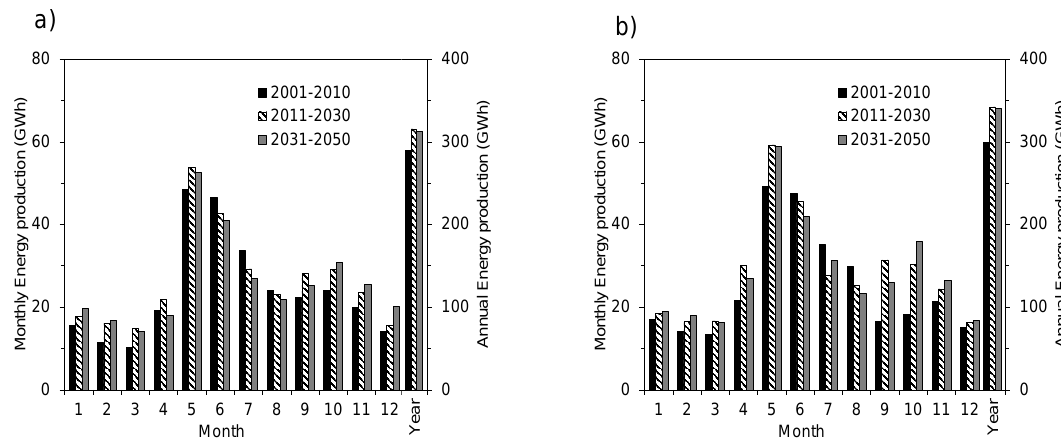
Figure 9. Average monthly and annual run of river hydropower production evaluated by the hydropower simulation model using the discharge dataset built starting from ( a ) REMO and ( b ) RegCM3 climatic scenarios.